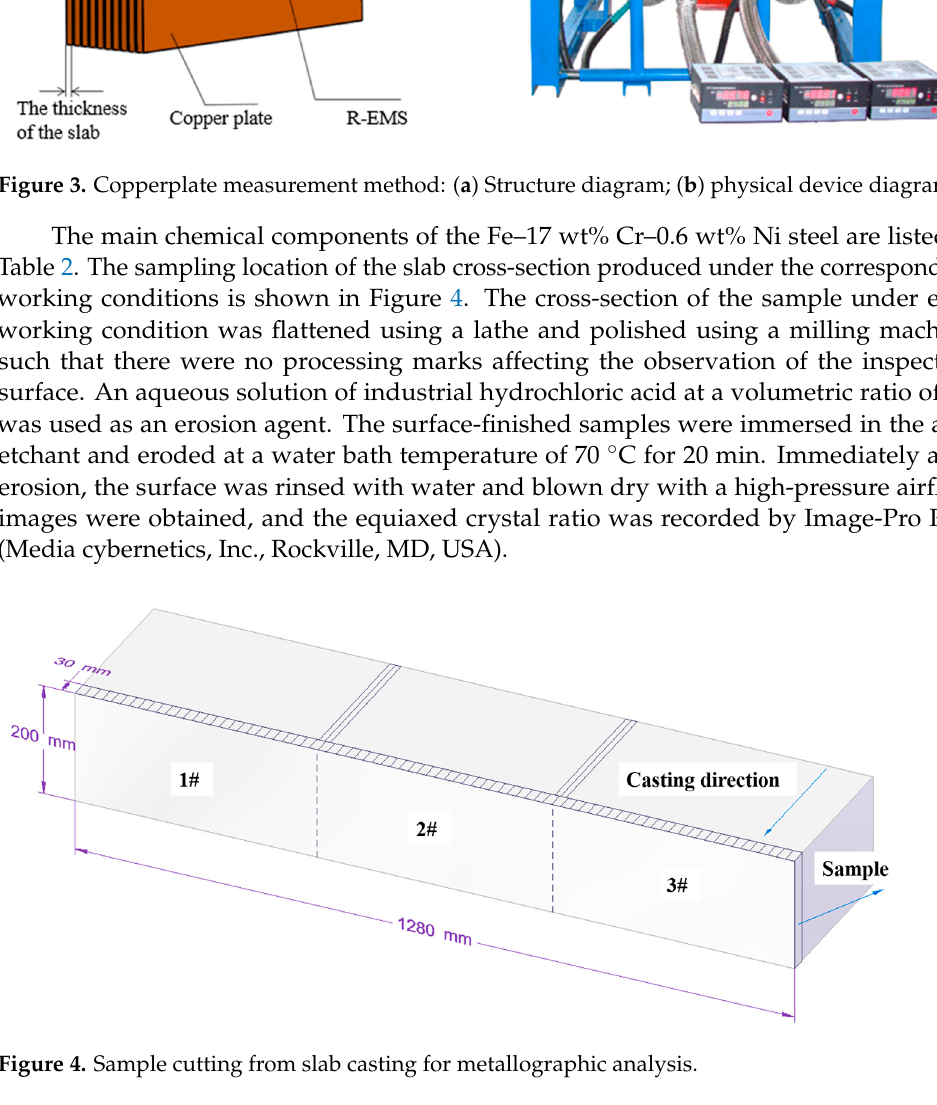
Figure 4. Sample cutting from slab casting for metallographic analysis.